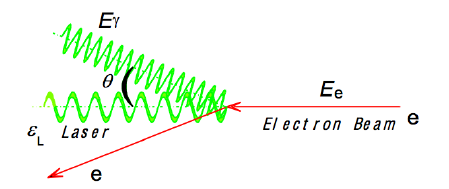
Figure 1. (Color online) Laser Compton